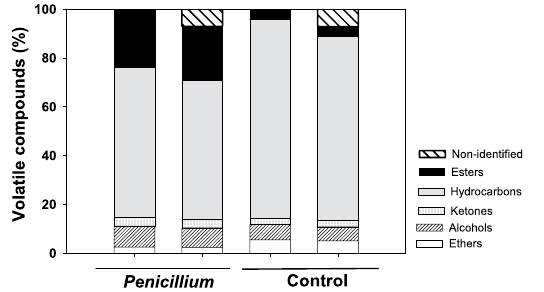
Figure 3. GCMS analysis of the volatile compounds emission in control and Penicillium- infested sweet orange ( Citrus sinensis ) fruits. Constituents are classified by chemical class: alcohols, esters, hydrocarbons, ketones, aldehydes, ethers and epoxides. For each treatment (control and Penicillium -infested) percentages are shown first without considering non-identified compounds and, then, considering them as an additional